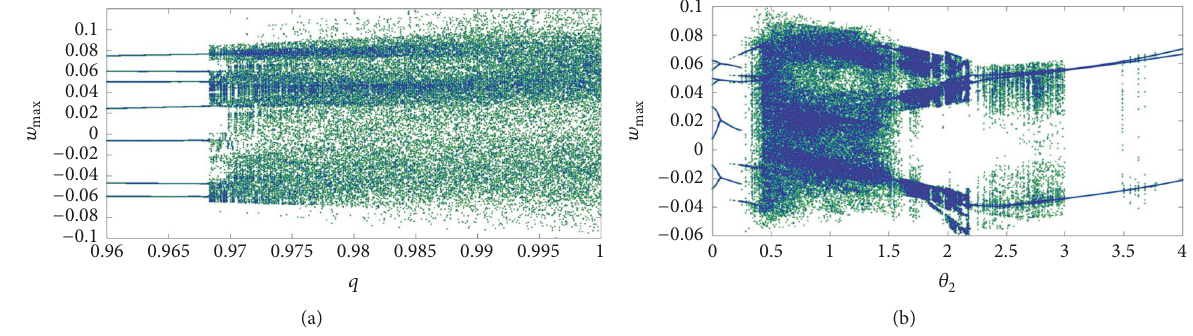
Figure 5: Bifurcation plots of 2DOFSMA oscillator with (a) commensurate fractional order 𝑞 and ( b ) parameter 𝜃 2 with 𝑞 = 0.99 and 𝜃 = 𝜃 = 1.5 . The initial conditions for plot (a) are taken as [0,0,0,1] and are reinitialized in end of each iteration to the final values of the 1 2 state variables and for plot (b) the initial value is fixed at [0,0,0,1] .